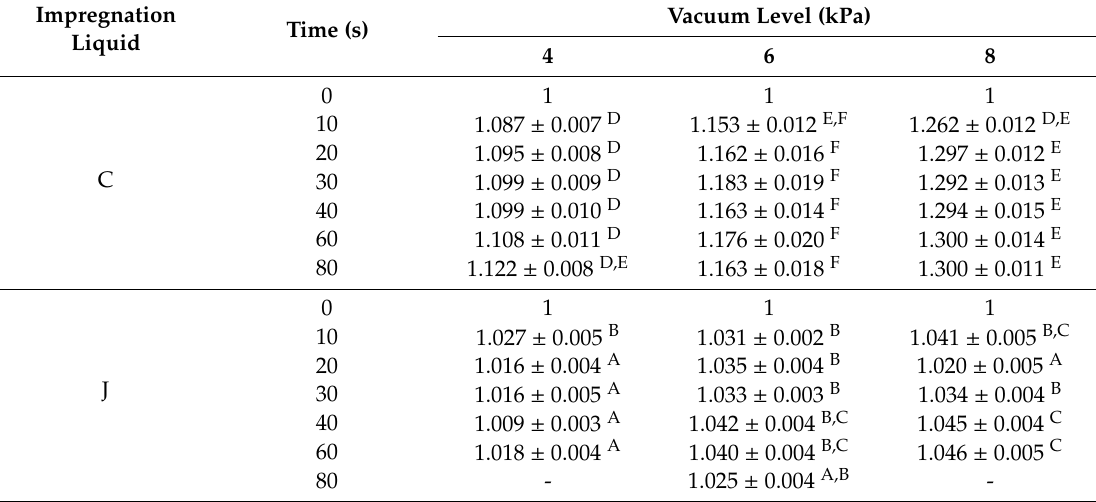
Table 1. Mass variation (MV) during vacuum impregnation (VI) of apples at varied vacuum pressures of 4, 6, and 8 kPa using citric acid solution (C), apple-pear juice (J), and distilled water (DW) as the impregnating